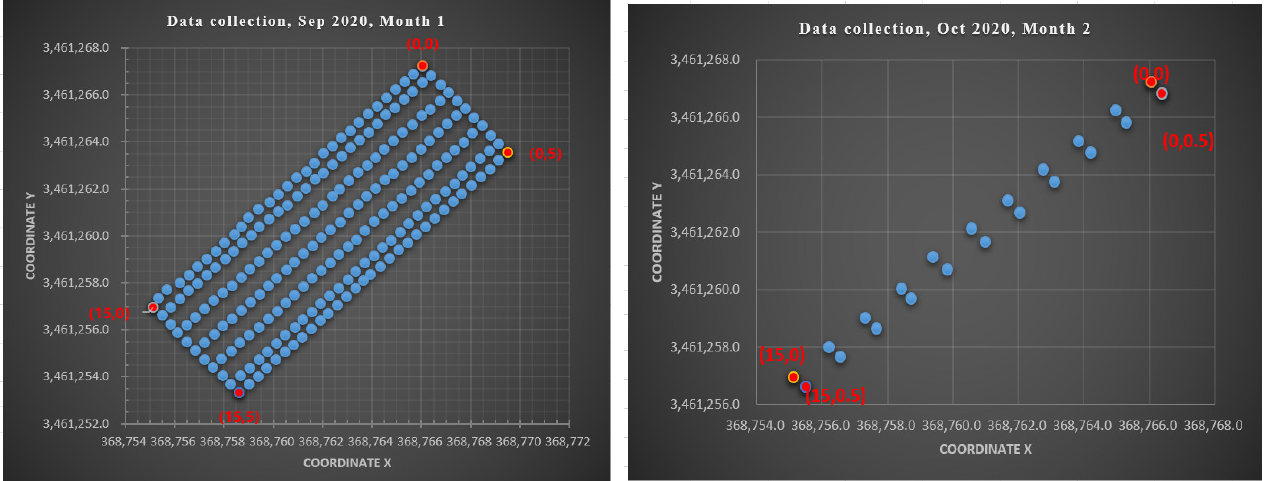
Figure 5. Distribution of the reference points for generating CSI-based fingerprints during September and October